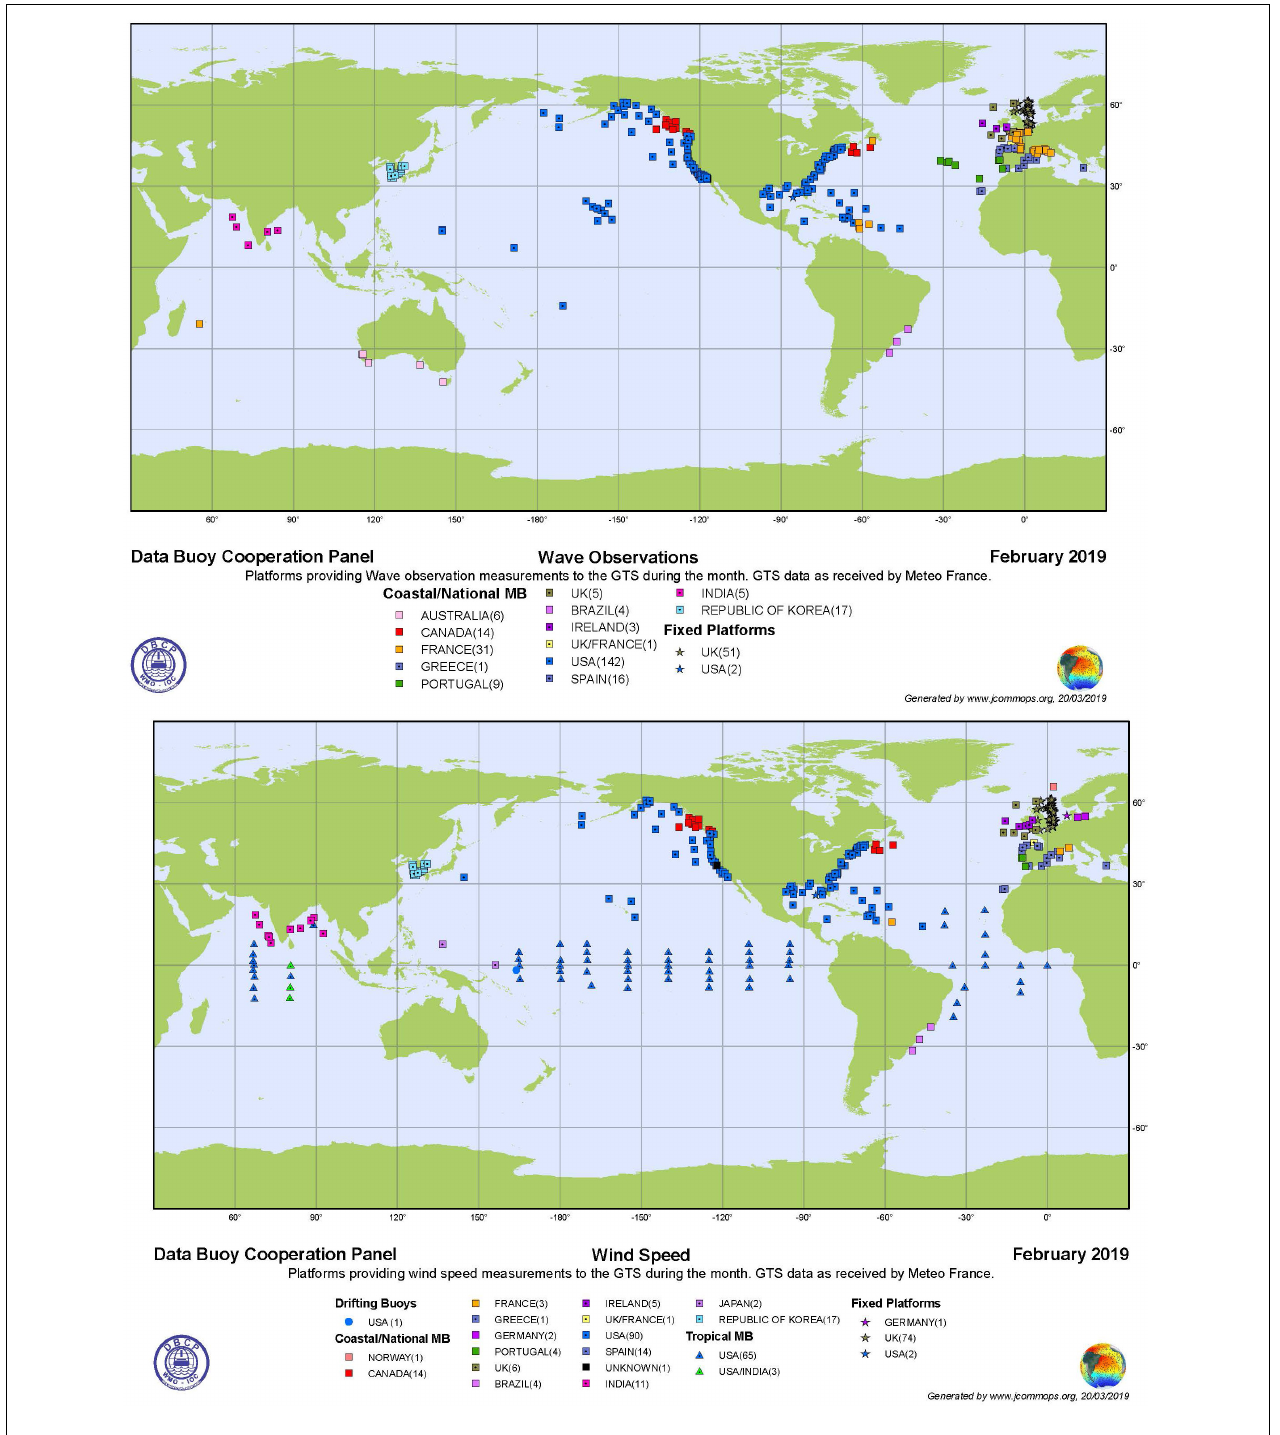
FIGURE 5 | Locations of wave (top) and wind (bottom) measurements.